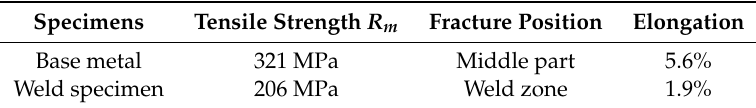
Table 7. Tensile test results.